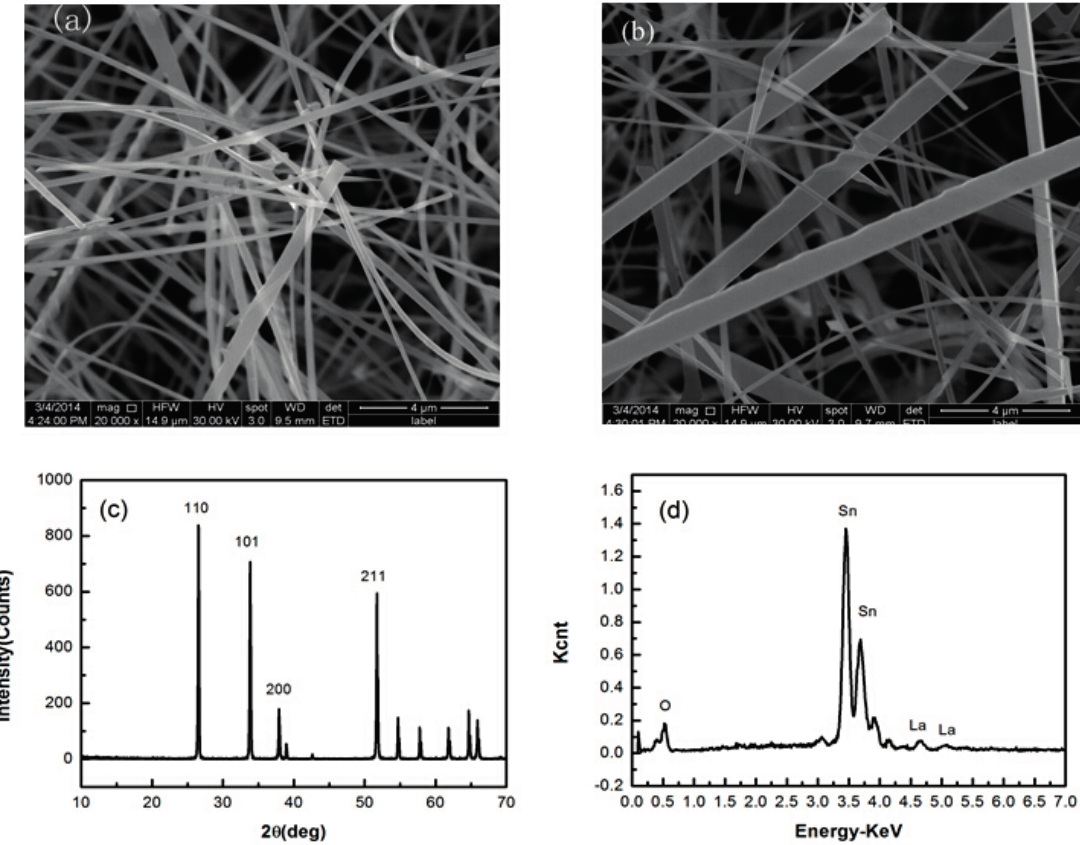
Figure 2. SEM images of La-SnO 2 NBs ( a ); SEM images of SnO 2 NBs ( b ); XRD and EDX patterns of La-SnO 2 NBs ( c ) and ( d ),